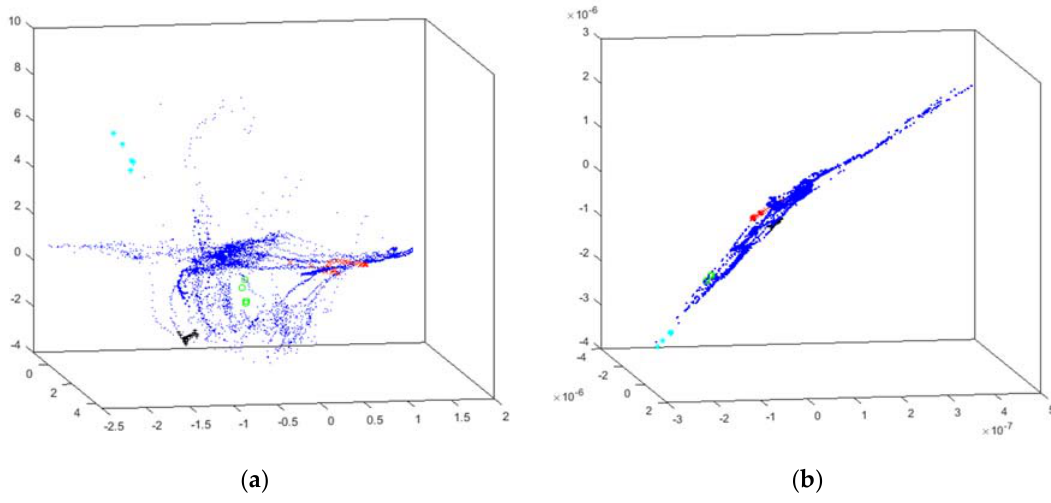
Figure 4. 3D visualizations generated by EPP methods for the intensifier dataset. ( a ) CMLH 3D visualization. ( b ) FA 3D visualization.